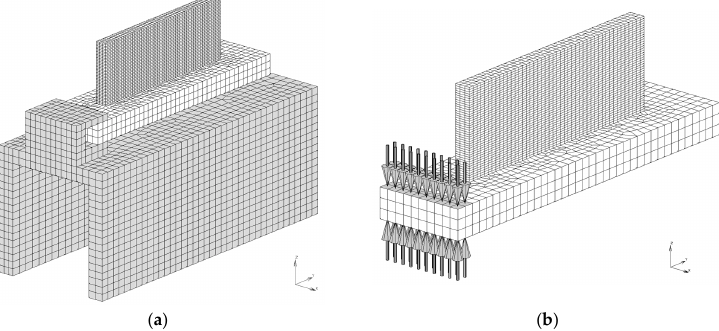
Figure 5. Simulation models. In ( a ) the fixture is meshed and in ( b ) the fixture is replaced by a convective boundary condition represented by the arrows. The total heat loss through the interfaces between the base plate and the fixture, and the temperatures in thermocouples TC 1 and TC 3, were compared for the two models. The value of the convective heat transfer coefficient was adjusted until the heat flux through the fixture interface and the temperatures in TC1 and TC3 were in good agreement; see Figure 6.